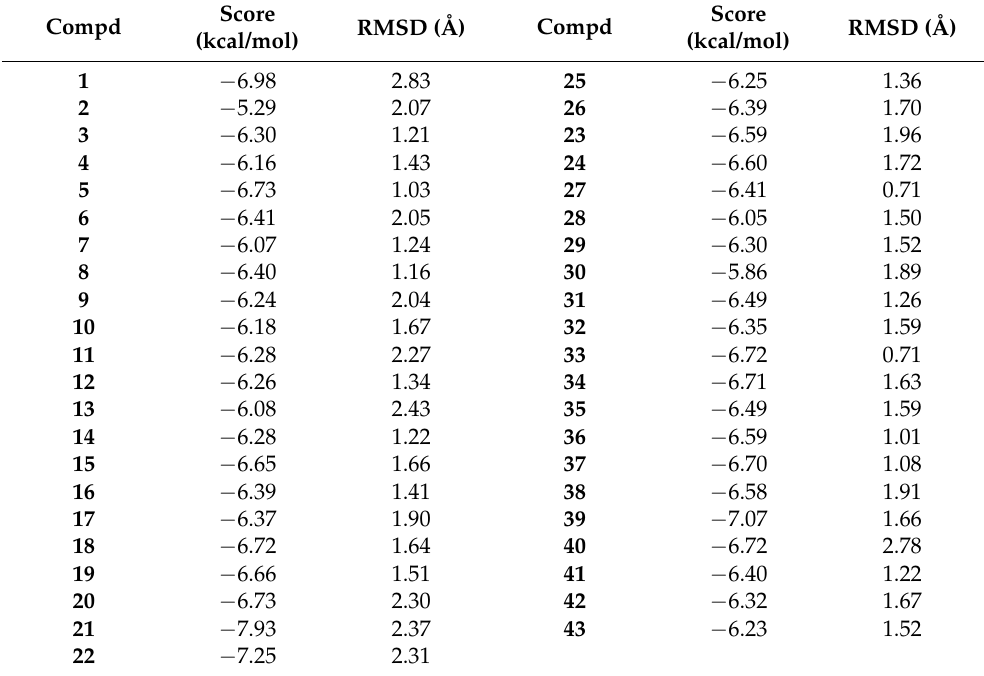
Table 4. Molecular docking score and RMSD of the 43 compounds under investigation.